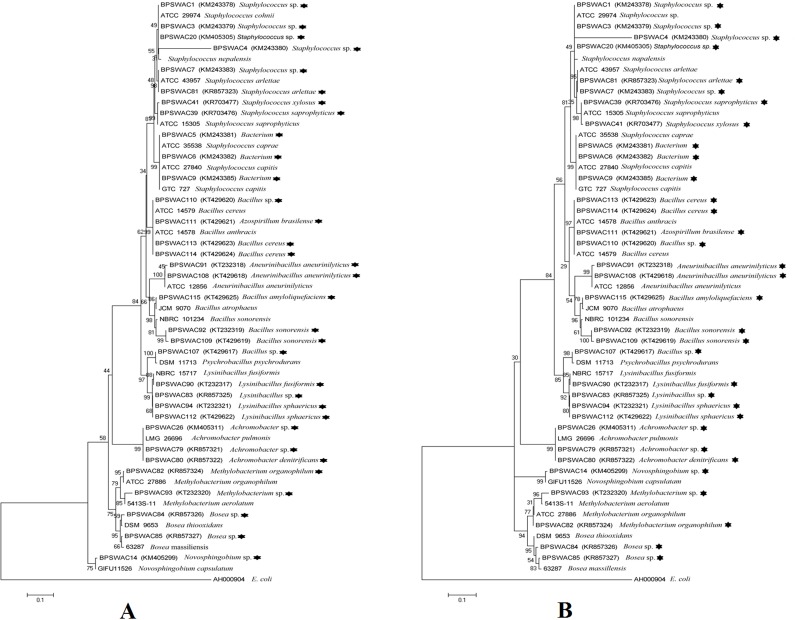
(A) Neighbor-joining phylogenetic tree based on 16S rRNA gene of bacteria identified from Tamdil Lake. (B) Maximum likelihood phylogenetic tree based on 16S rRNA genes. Numbers at branches indicate bootstrap values of neighbour-joining analysis (>50%) from 1,000 replicates.